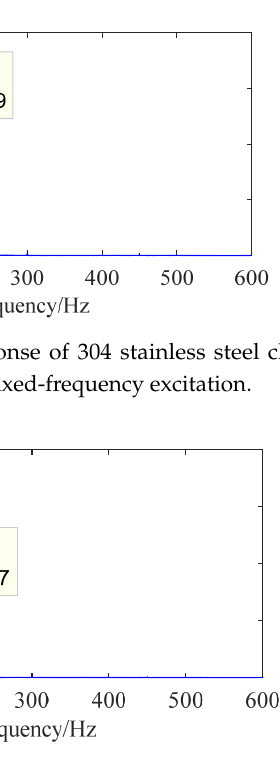
Figure 14. Vibration response of galvanized iron clamp with a 150- μ m-thick hard coating of Z r O 2 - PTFE under 150 Hz fixed-frequency excitation.